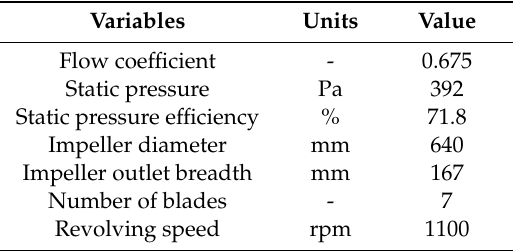
Table 1. Rated variables of the plenum